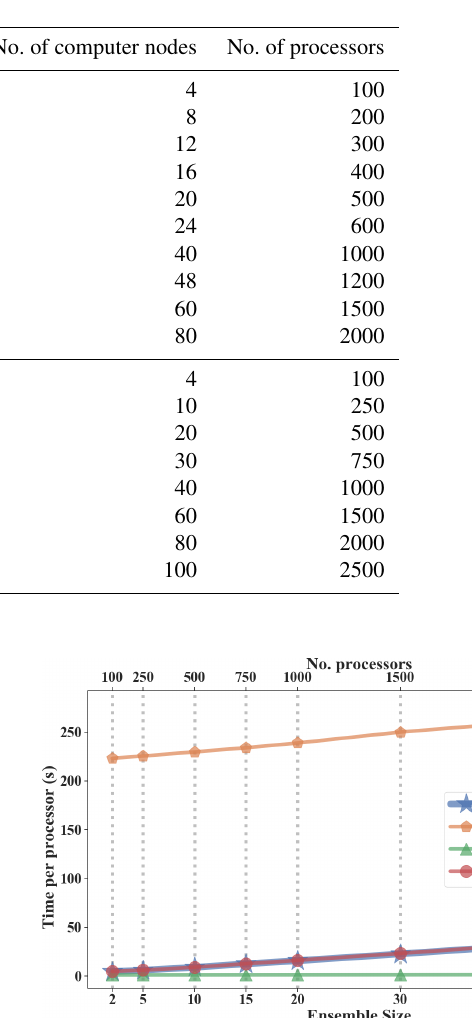
Table 2. Number of realizations, compute nodes, and processors utilized for the study of strong and weak parallel efficiency for the NAQPMS- PDAF. The number of cores within one compute node is set as 25.